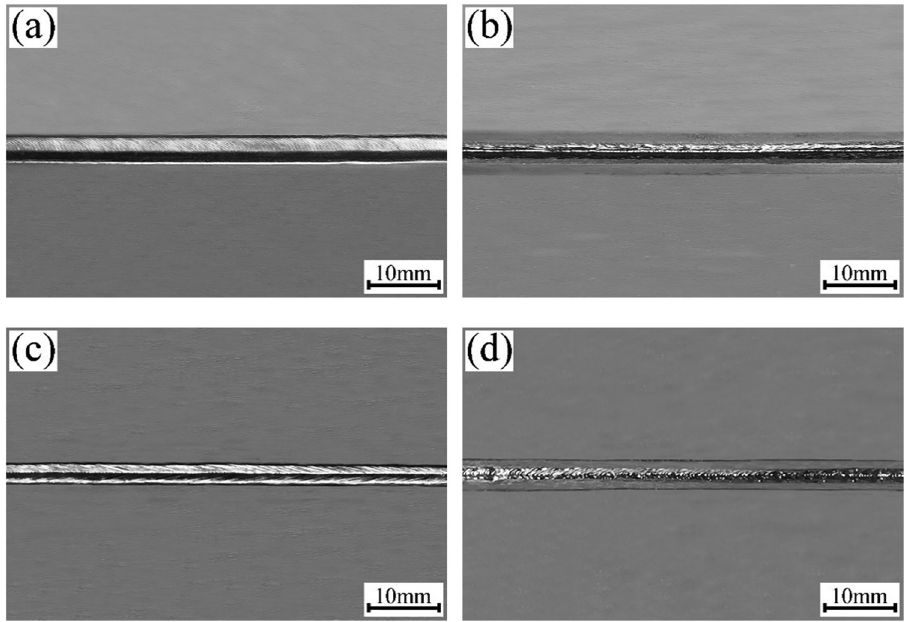
Figure 4: Appearance of weld: ( a ) top surface of EBW joint, ( b ) root surface of EBW joint, ( c ) top surface of P - LBW joint, and ( d ) root surface of P - LBW